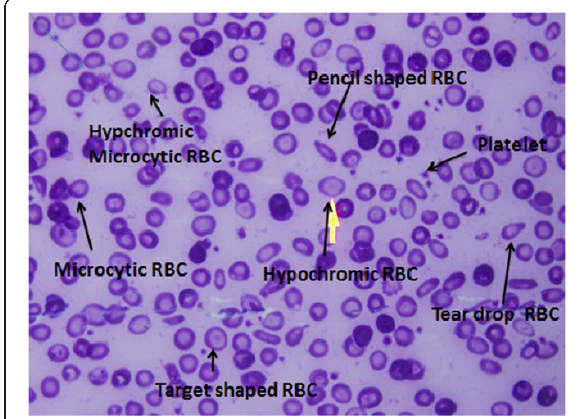
Figure 1 Peripheral blood film with changes attributed to iron deficiency